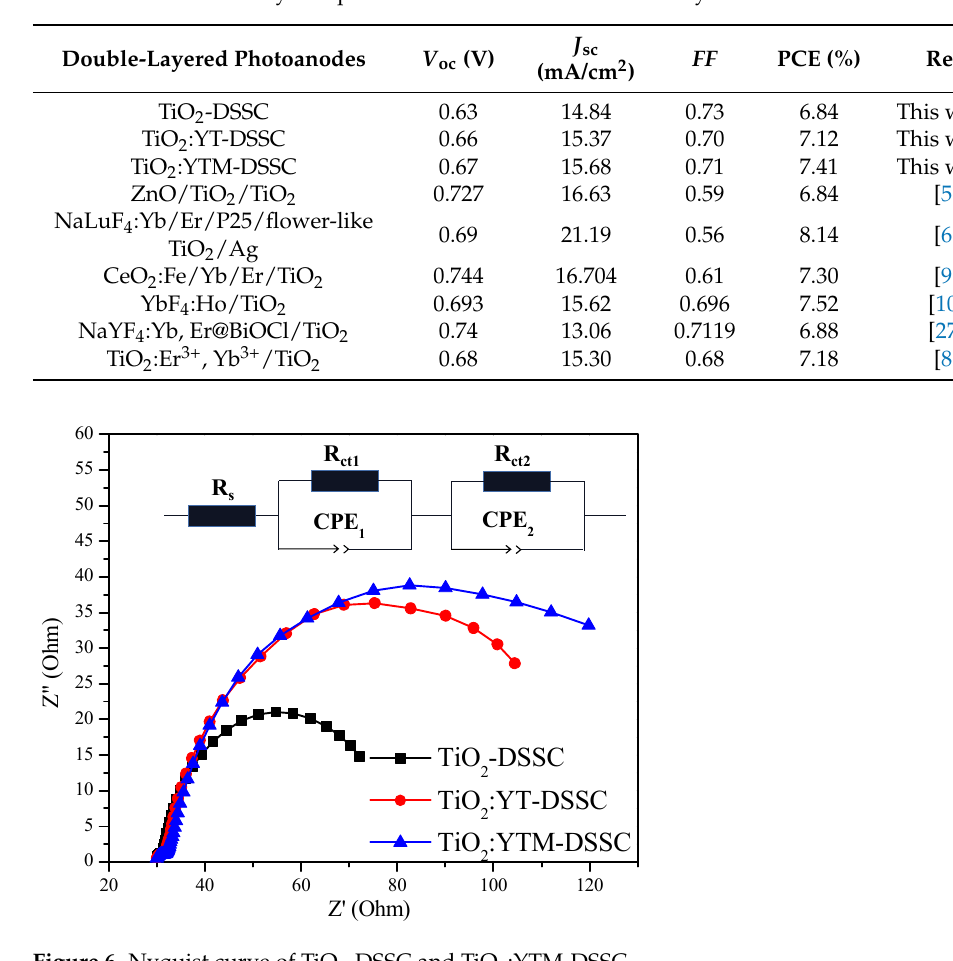
2 -DSSC and TiO 2